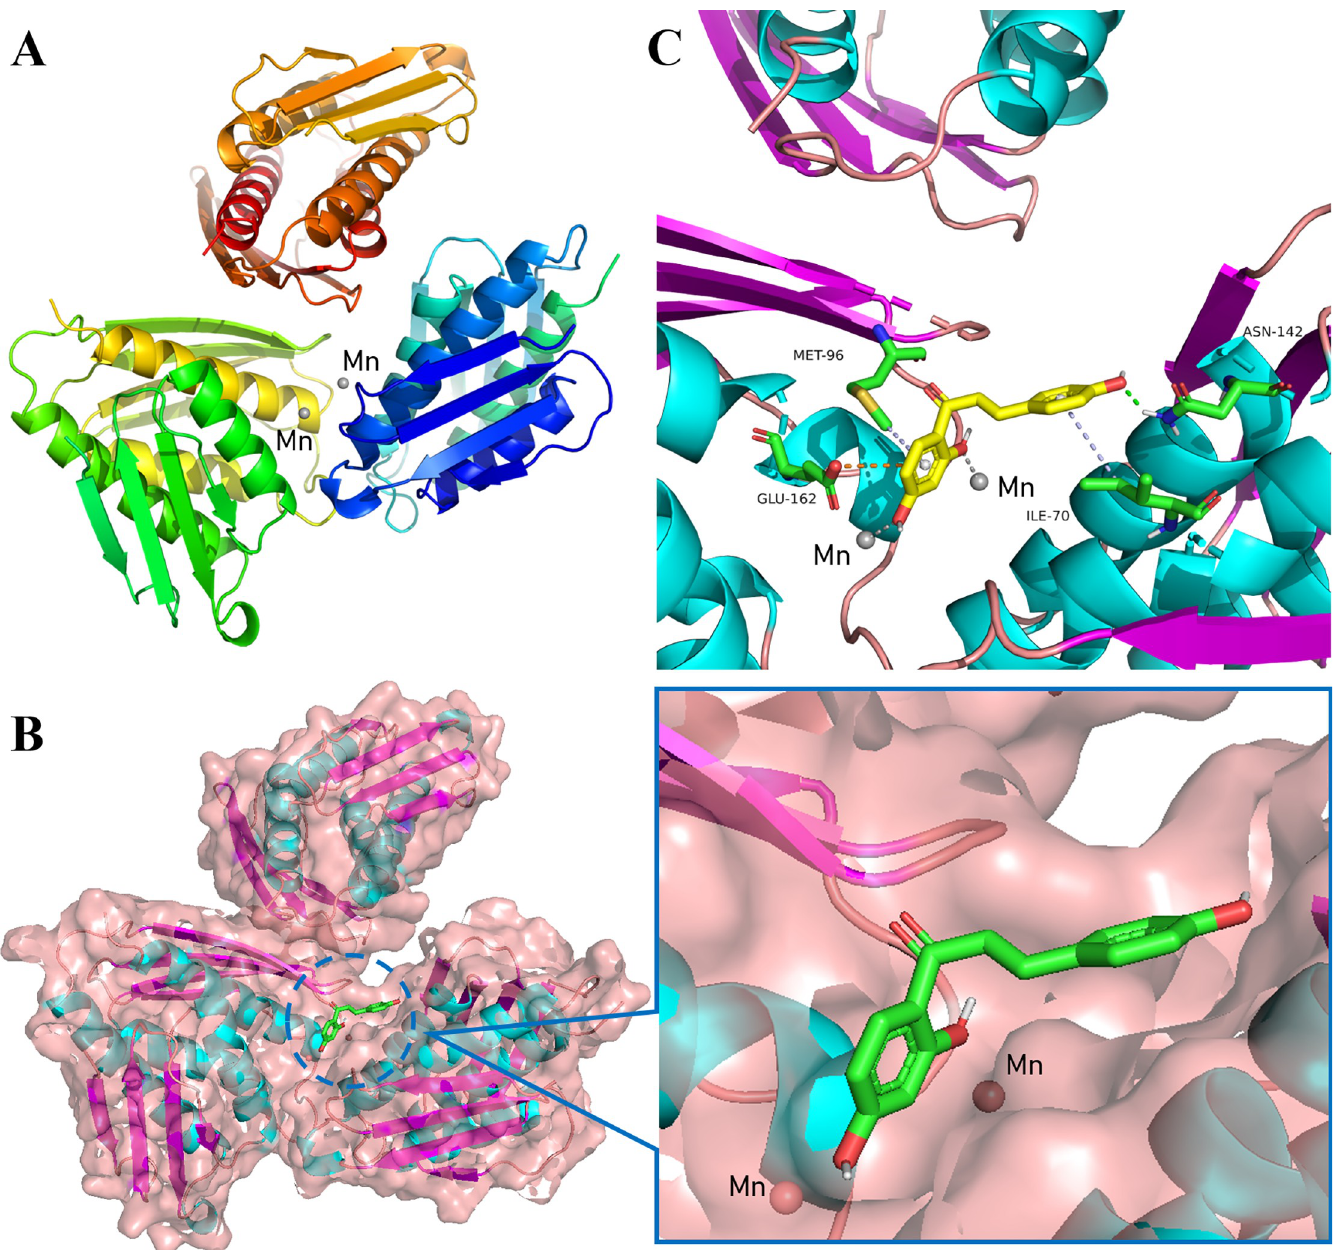
Fig 7. Computer methodological analysis. (A) Tertiary structure model of S . xylosus IGPD. (B) Determination of the 3D structure of the IGPD-ISL complex using a molecular modeling method. (C) The predicted binding mode of IGPD with the ISL is shown, with labeling of key residues in the binding sites.